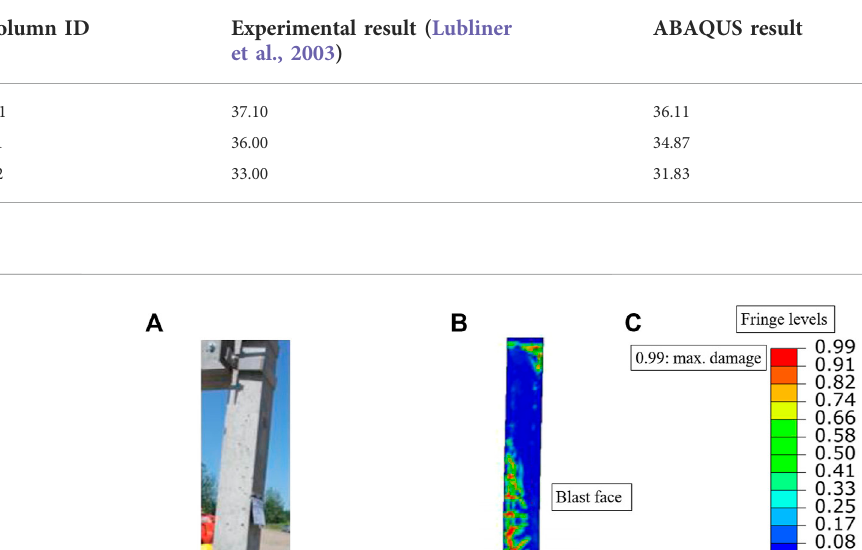
TABLE 2 Comparison of maximum transverse mid-height displacement (mm).